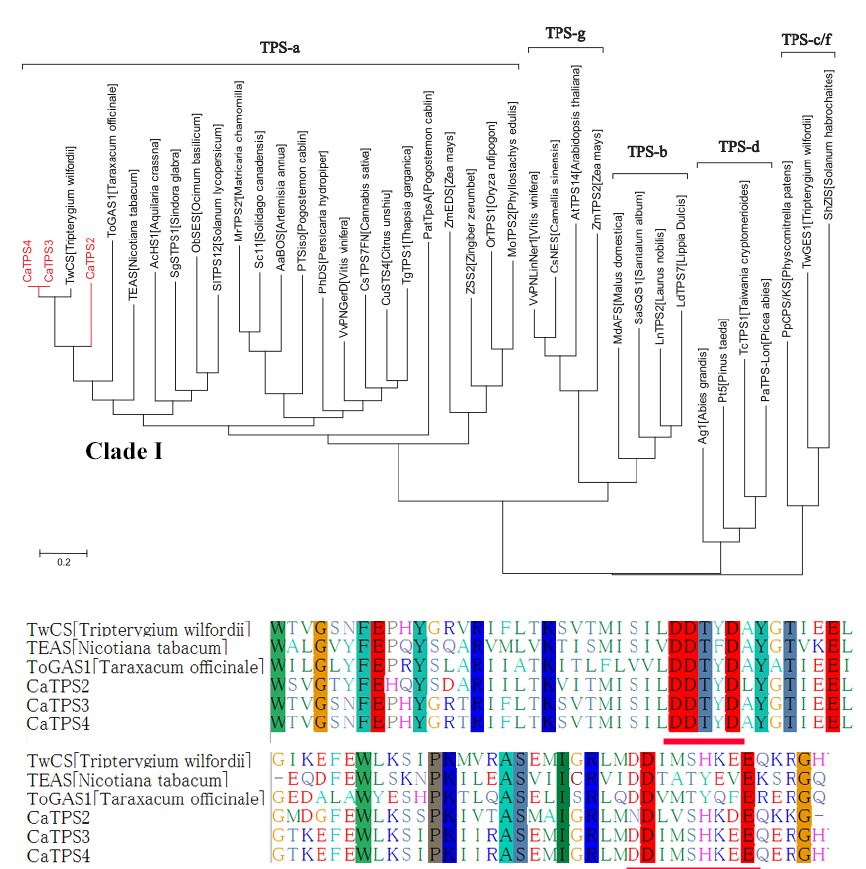
Figure 8. The phylogeny of candidate STSs in C. angulatus . Red branches represent the CaTPSs . The red underlines show the conserved DDxxD and NSE/DTE motifs.